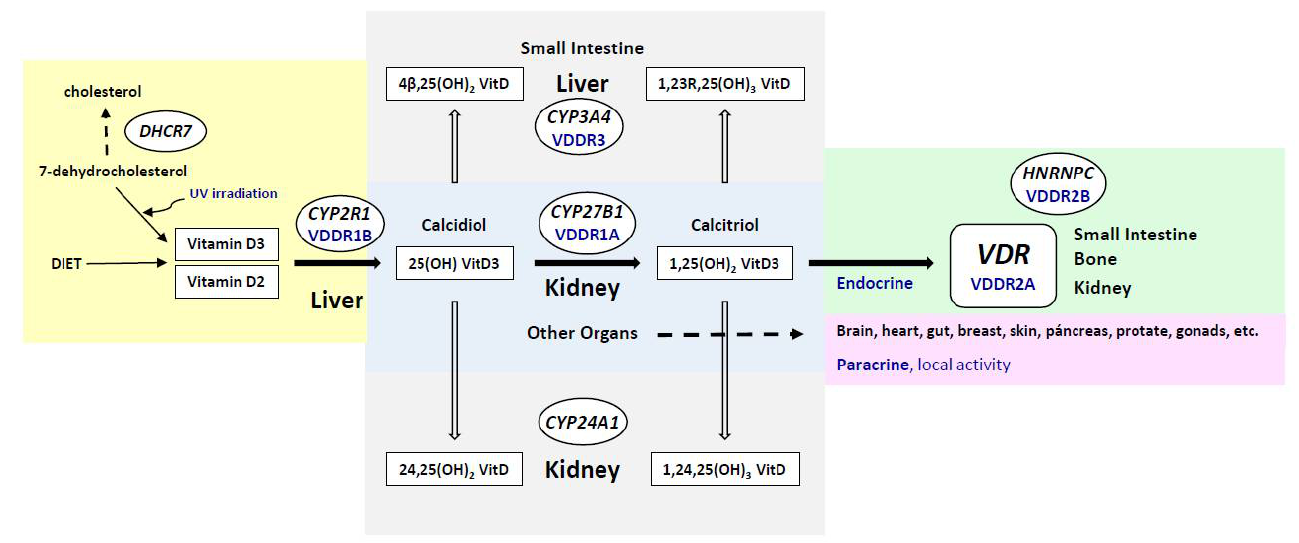
Figure 1. Schematic representation of VDES metabolism and the main genes involved. The CYP2R1 , CYP27B1 , CYP24A1 , and CYP3A4 genes encode the enzymes vitamin D 25-hydroxylase, 25-hydroxyvitamin D3-1-alpha-hydroxylase, vitamin D 24-hydroxylase and cytochrome P450 3A4, respectively. The VDR gene encodes the vitamin D receptor. The DHCR7 gene encodes delta-7-dehydrocholesterol reductase. The HNRNPC gene encodes Heterogeneous Nuclear Ribonucleoprotein C. VDDR1A, vitamin D-dependent rickets type 1A; VDDR1B, vitamin D hydroxylation-deficient rickets type 1B; VDDR2A, vitamin D-dependent rickets type 2A; VDDR2B, vitamin D-dependent